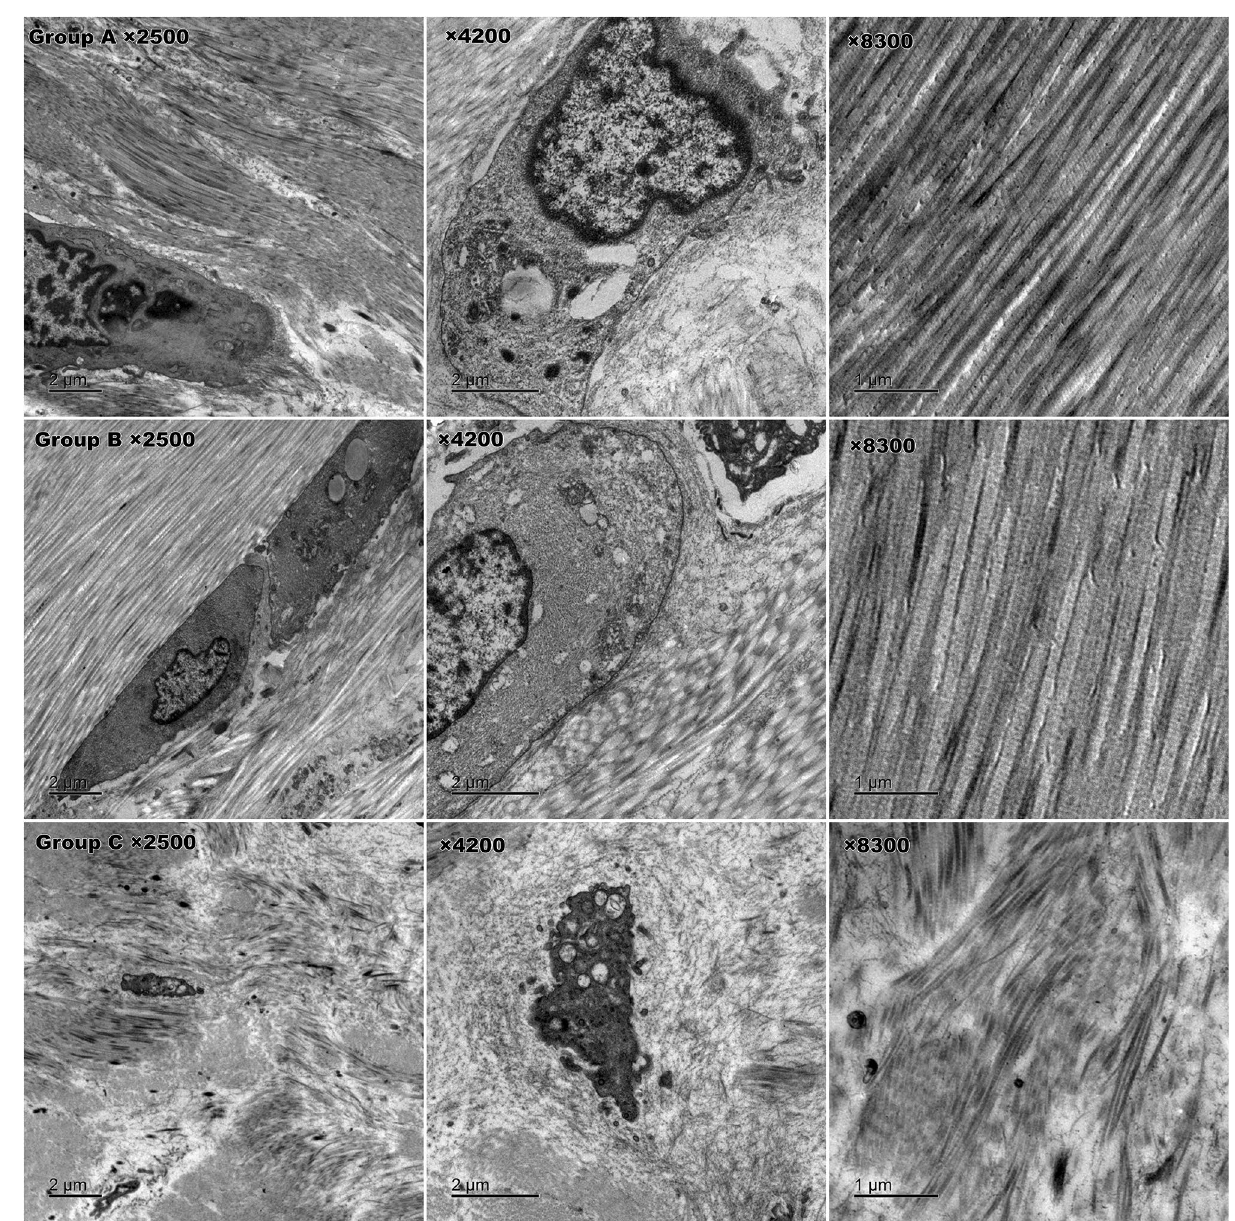
Figure 6. Ultrastructure of rotator cuff tissue under transmission electron microscopy. In group C, nuclear chromatin pyknosis with indistinct cytosolic organelles and distorted or broken fibrils were observed, which significantly differed from groups A and B (bottom